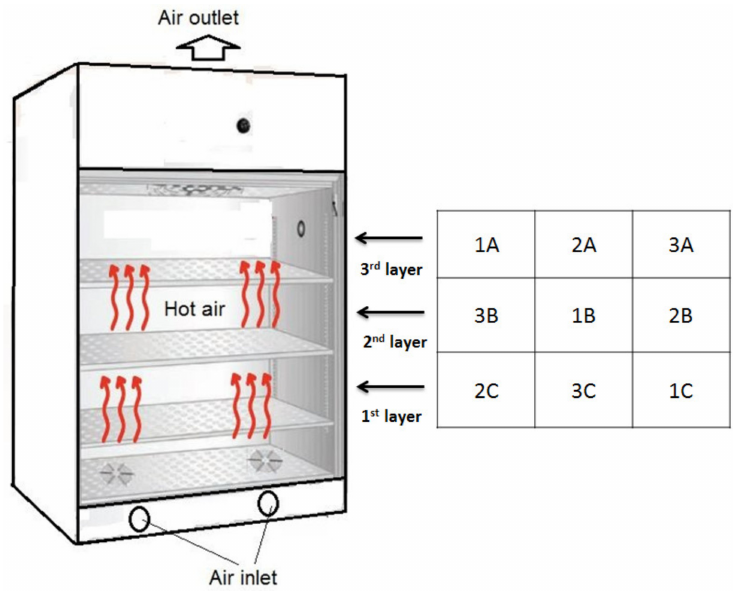
Figure 1. Scheme of the drying chamber and test